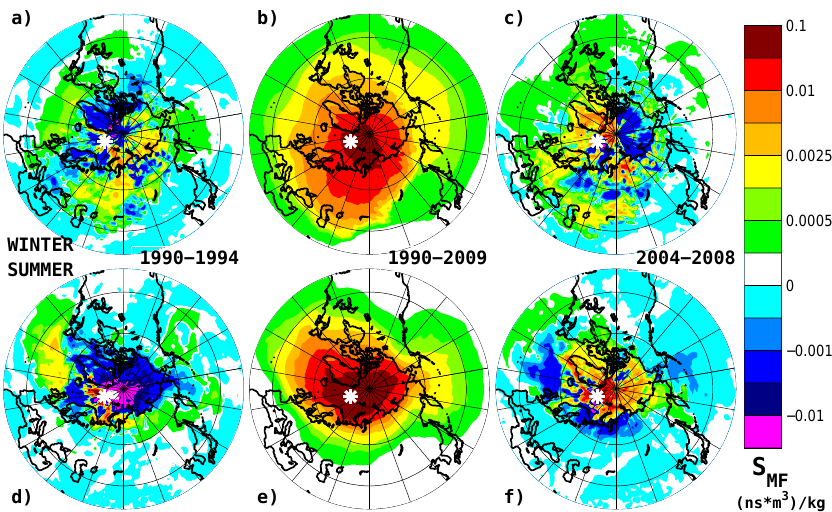
Fig. 4. Transport climatologies ( S MF ) at Zeppelin during winter (upper row of panels) and summer (lower row). The middle column shows the mean S MF , averaged over the whole time period (1990–2009). The left column of panels illustrates the difference from the mean flow for the early period 1990–1994, and the right column illustrates the difference from the mean for the late period 2004–2008. The station’s location is marked with a white asterisk.